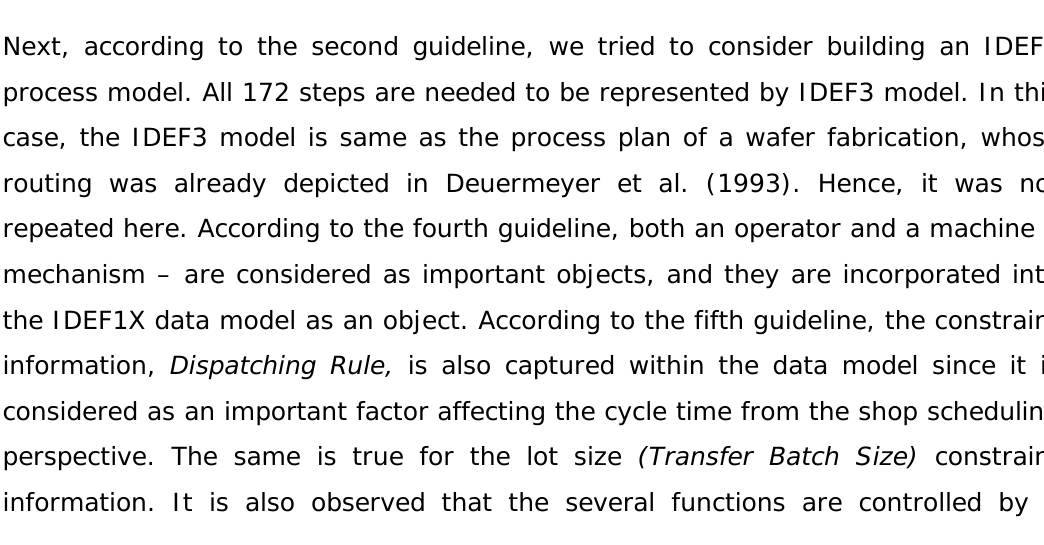
Figure 6. “Function model of a fabrication process in strip